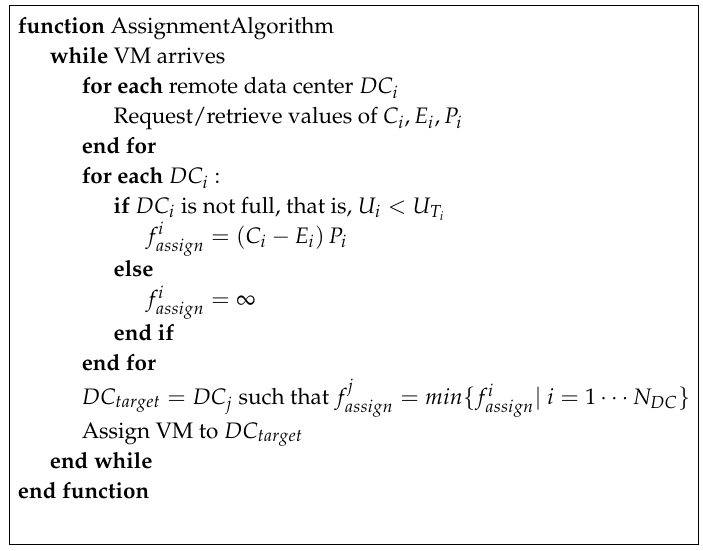
Figure 3. The EcoMultiCloud assignment algorithm, executed by the DCM of each data